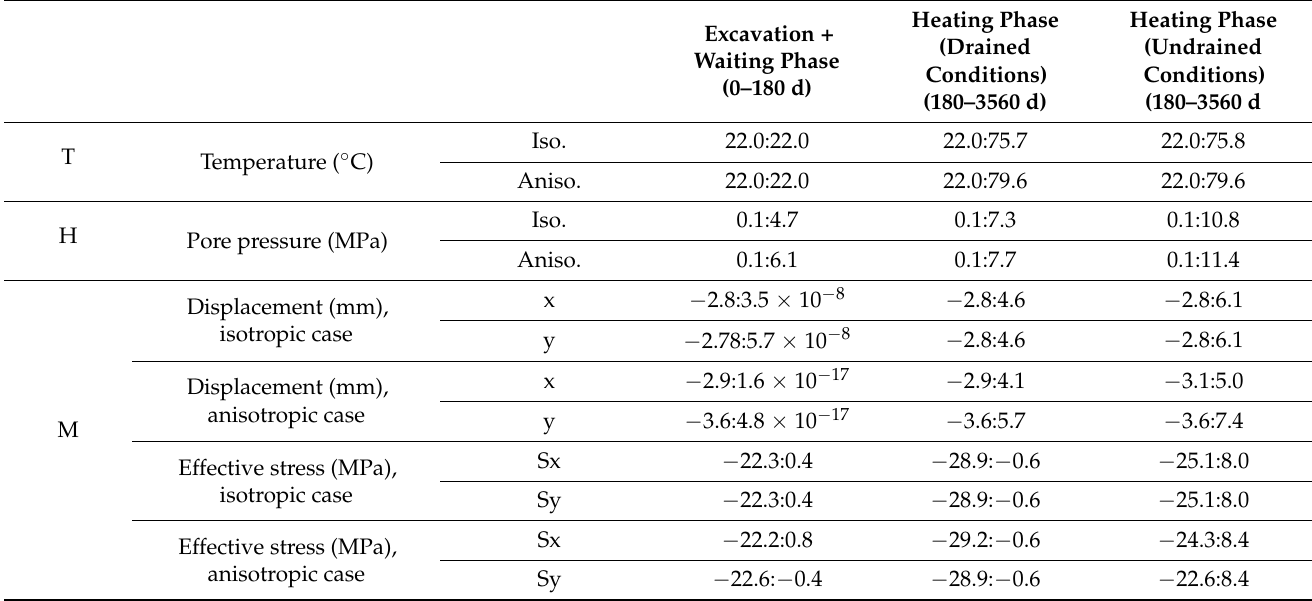
Table 5. Minimal and maximal values in the model